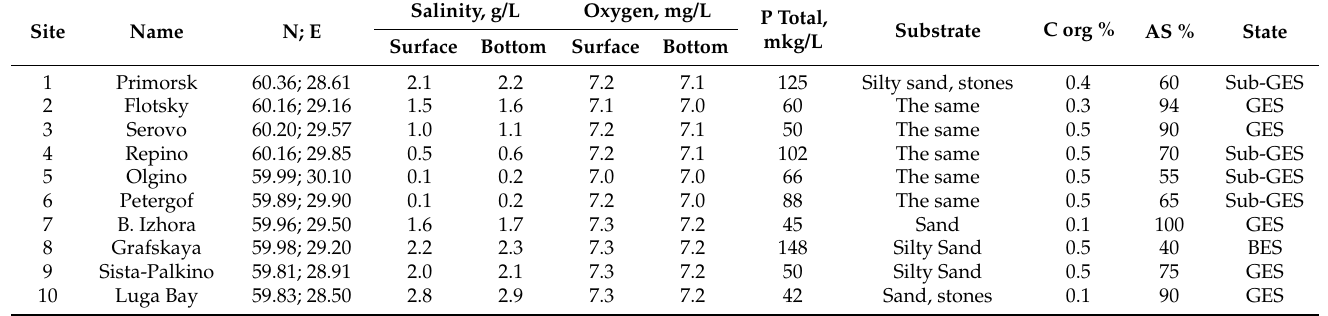
Table 1. Study sites’ location, physical, and chemical characteristics. P is phosphorus and C is carbon in sediment, AS is amphipod survival, GES and BES mean good and bad environmental state.